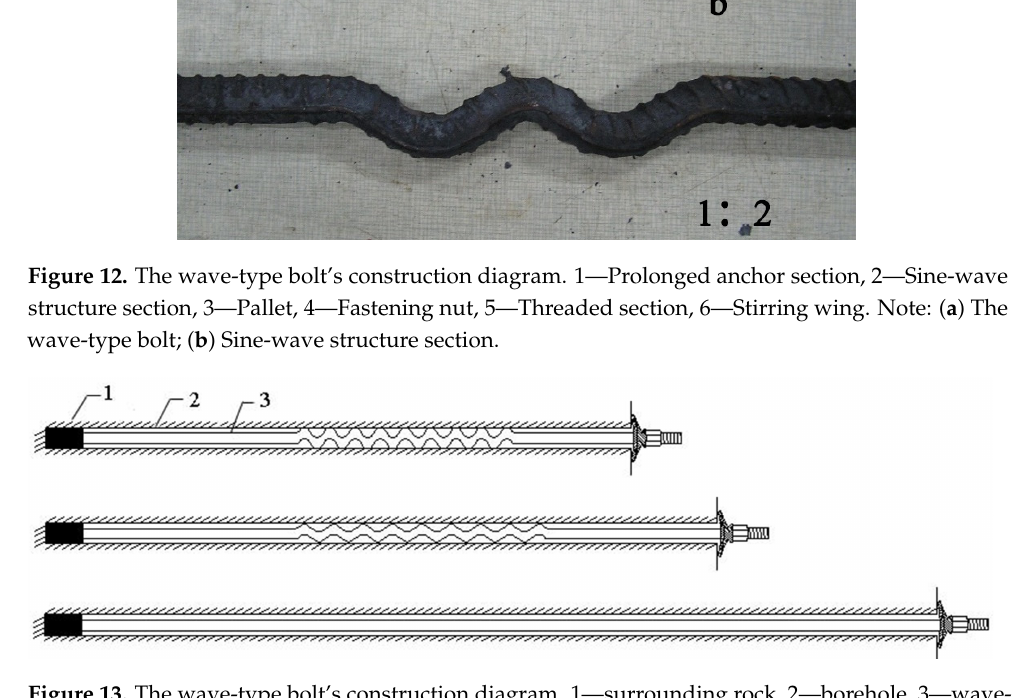
Figure 13. The wave-type bolt’s construction diagram. 1—surrounding rock, 2—borehole, 3—wave-type bolt.